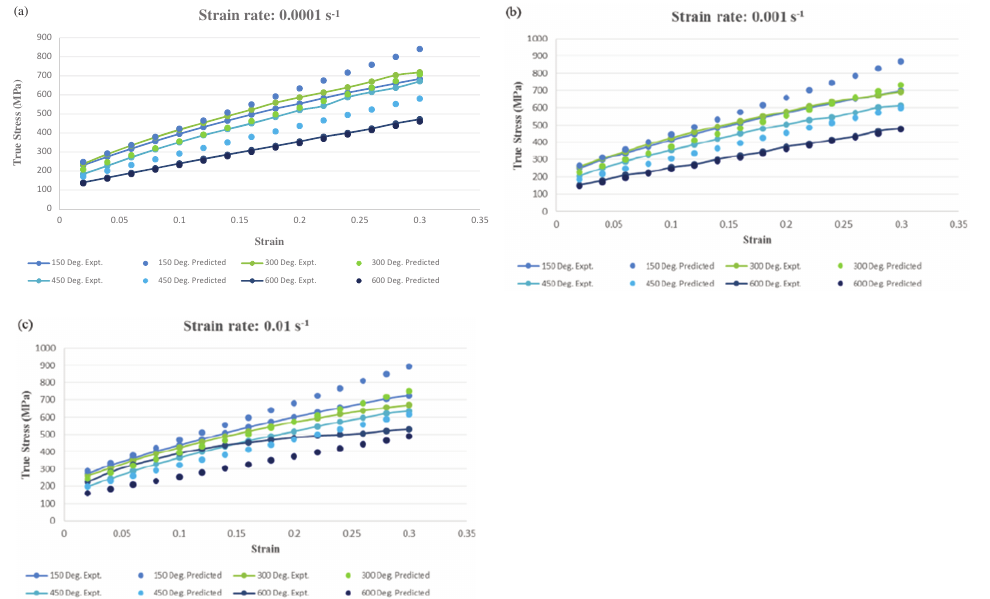
Figure 6: Comparisonof experimentalandpredictedflowstressfor KHL modelforASS316 forstrainrates of (a)0.0001s − 1 (b) 0.001s − 1 (c) 0.01s − 1 .